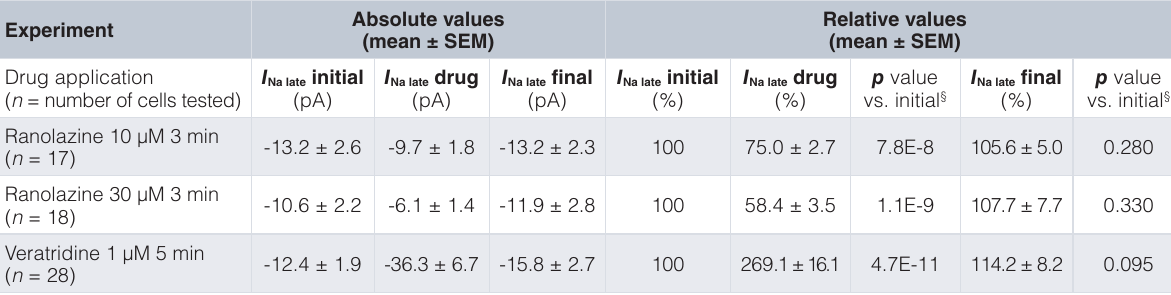
Table 1. Effects of ranolazine 10 and 30 μM and veratridine 1 μM on TTX-sensitive * late Na + current. Experiment